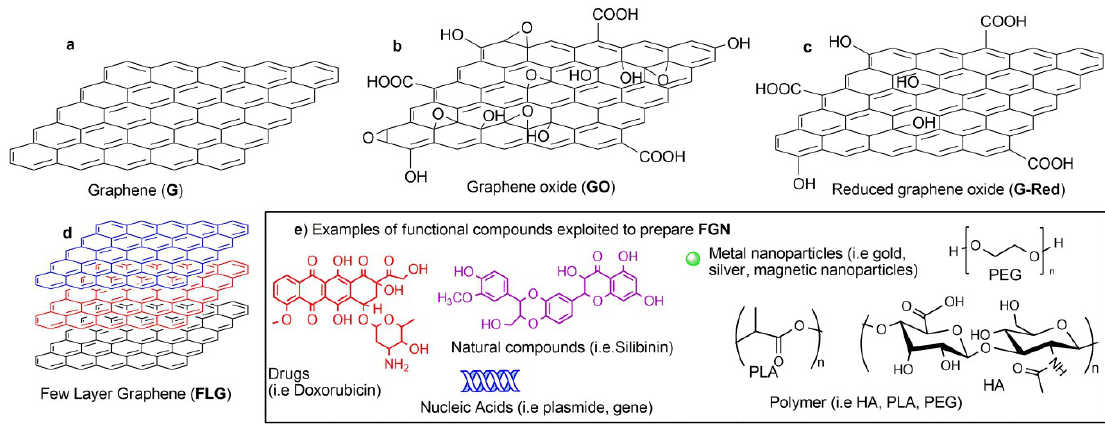
Figure 1. The summary of structural models of various graphene derivatives. ( a ) Pristine graphene (G), ( b ) graphene oxide (GO); ( c ) reduced graphene oxide (G-Red); ( d ) few-layer graphene (FLG); ( e ) some examples of functional compounds exploited to prepare Functional Graphene Nanomaterials (FGN).